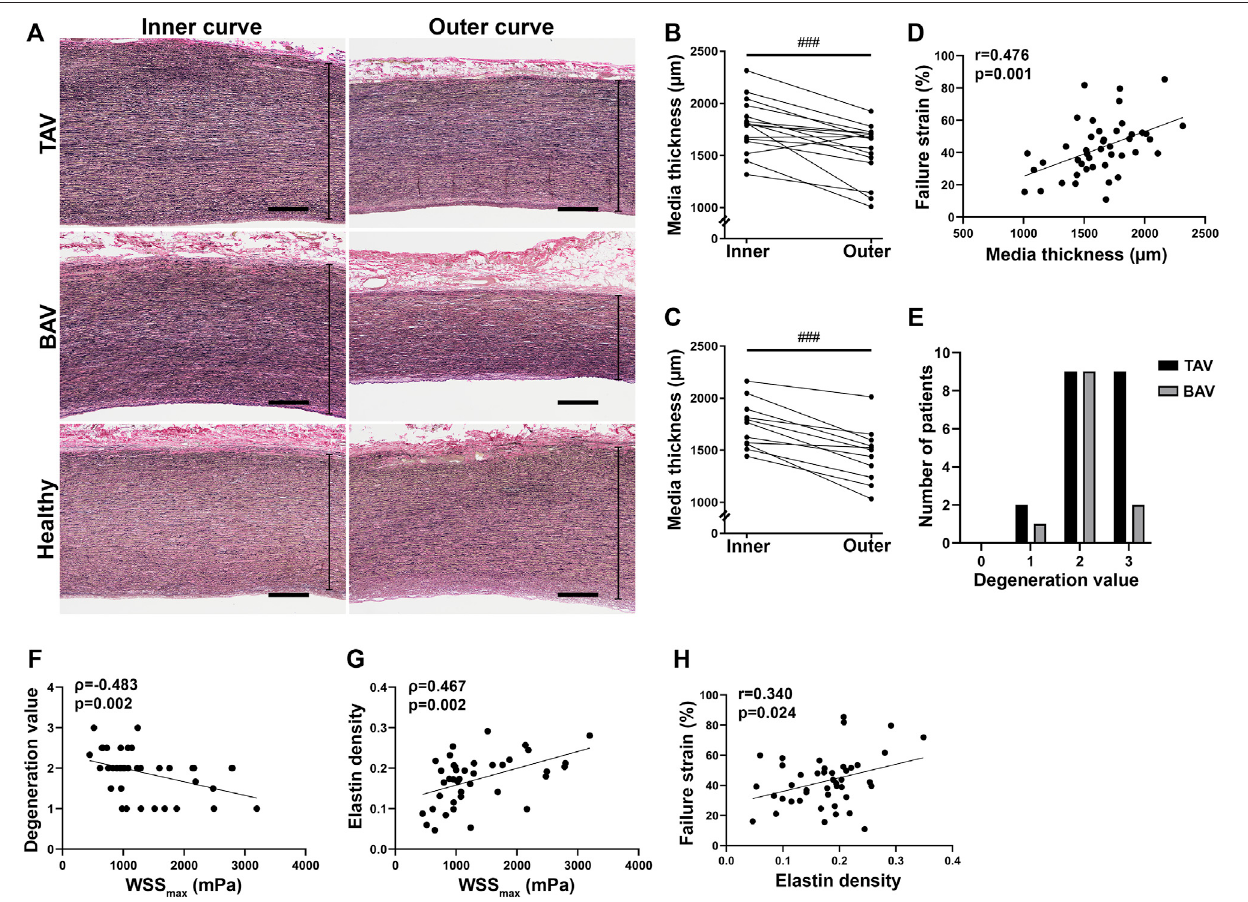
FIGURE 4 | (A) Representative images of medial layer in the inner and outer curves. Scale bars, 500 µm. (B,C) Media thickness of the inner and outer curves of dilated AA with TAV (B) and BAV (C) . (D) Correlation was detected between media thickness and failure strain in all patients with TAA. (E) Moderate to severe media degeneration was observed in TAA patients. (F,G) Correlations were detected between maximum total WSS and media degeneration (F) and elastin density (G) . (H) Correlation was detected between elastin density and failure strain in all patients with TAA. p -values < ### 0.001. Non-parametric test.